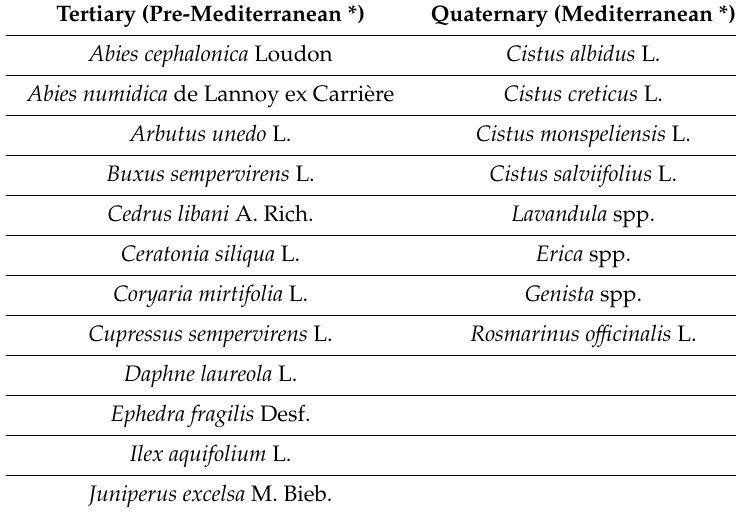
Table 1. Mediterranean evergreen woody species listed on the basis of the era of